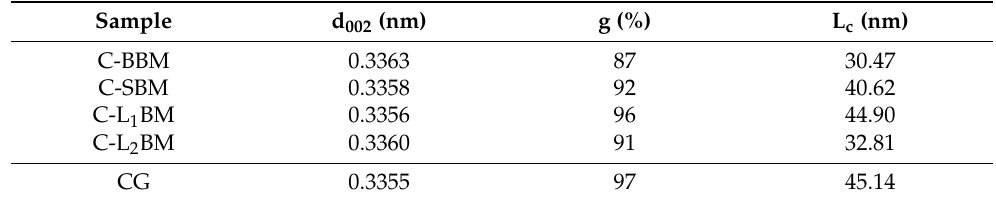
Table 3. Structural parameters calculated for the graphite samples. CG stands for commer- cial